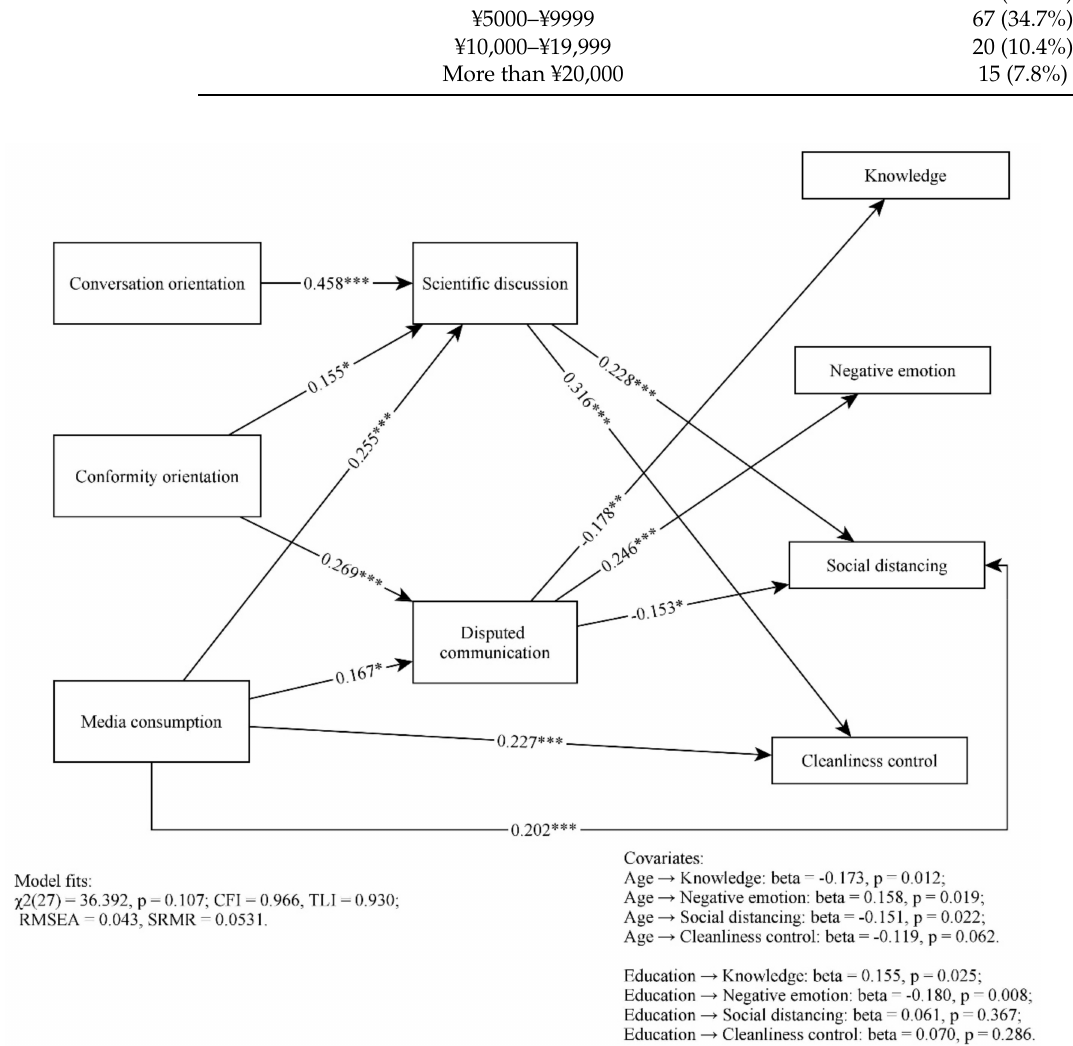
Figure 2. Path analysis of the hypothesized model. *** p < 0.001; * p < 0.05. H1 predicted positive relationships between media exposure and the older genera- tion’s health-related outcomes. The results suggested that media exposure was a positive predictor of negative emotions ( β = 0.065, p = 0.010) and two preventive behaviors (for social distancing: β = 0.202, p = 0.008; for cleanliness control: β = 0.227, p = 0.003).